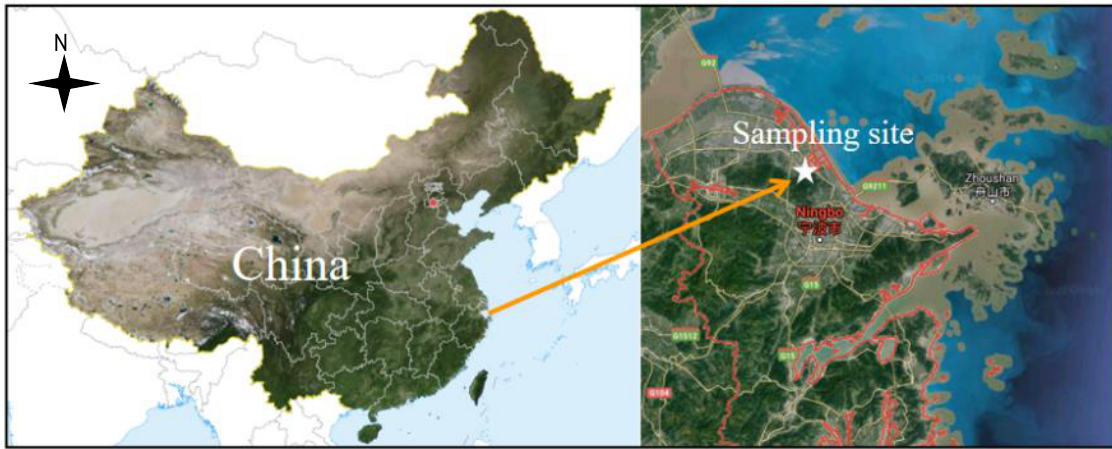
Figure 1. Location of sampling site (121°32′ E, 30°30′ N) on the map, which is located in the north of Ningbo.